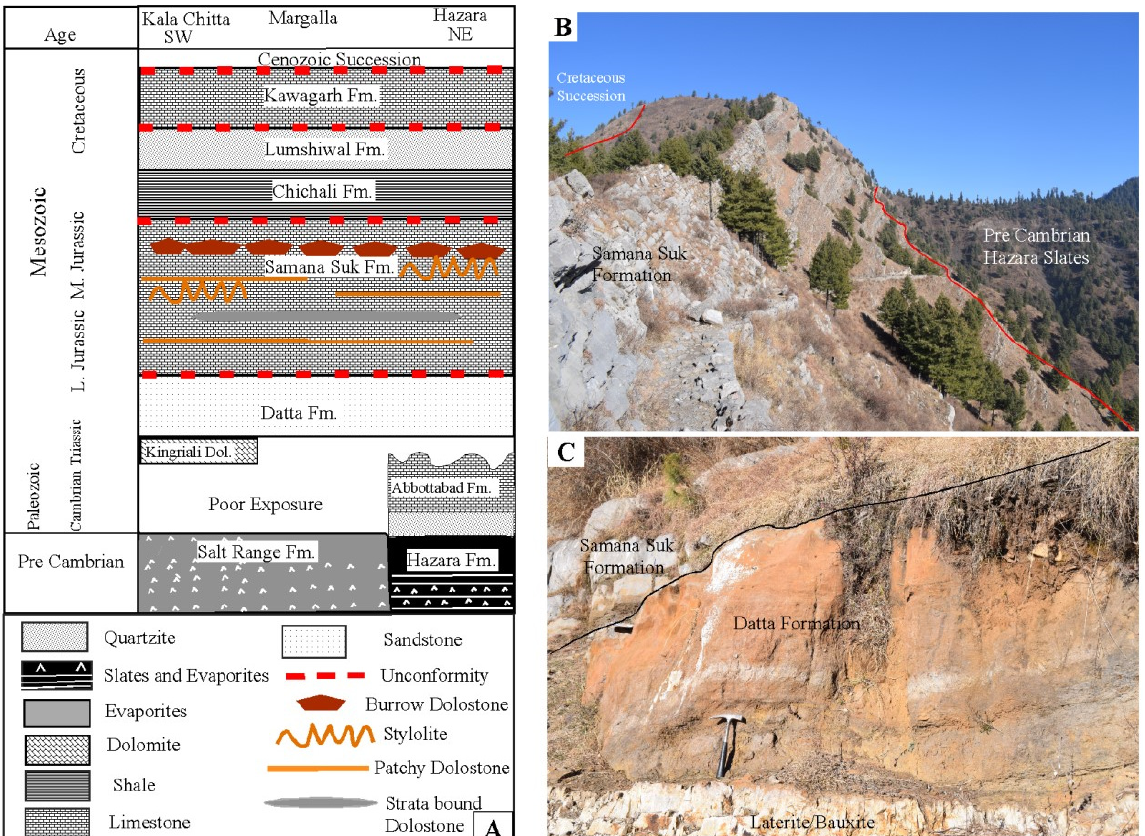
Figure 2. ( A ) The lithostratigraphic column of the Lesser Himalayas represents the major Mesozoic stratigraphic units and pronounced hiatuses (modified after Ahsan et al., [28]). Note that dolomi- tization only affects the Samana Suk Formation. ( B ) A panoramic photograph of the Samana Suk Formation representing top and bottom contacts. ( C ) Bottom contact of the Samana Suk Formation with the Datta Formation. Laterite/bauxite horizons are observed in the Datta Formation.